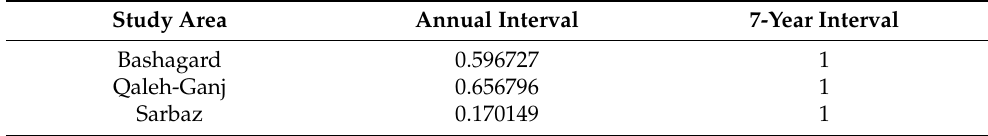
Table 4. Correlation between VCI and